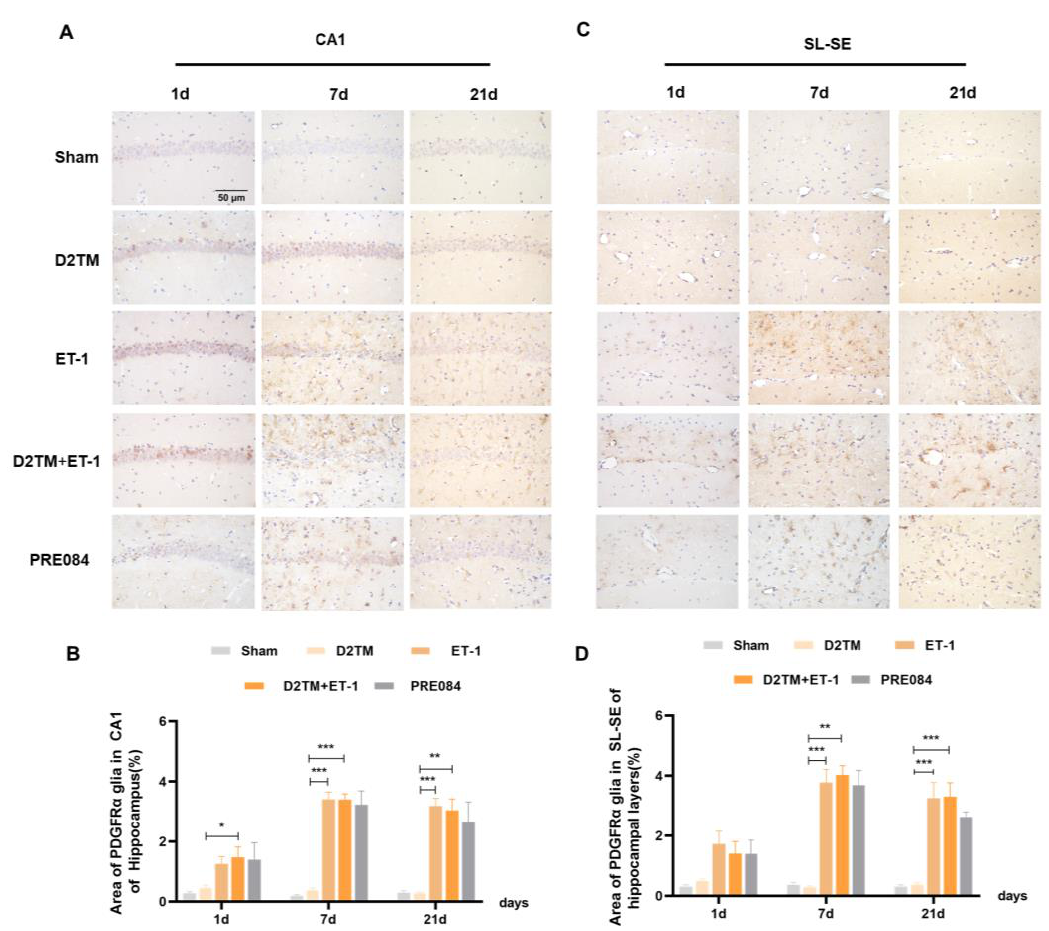
Figure 9. PRE084 regulated the expression of PDGFR α in stroke in diabetic mice. ( A , C ) PDGFR α immunohistochemistry was performed to detect oligodendrocyte progenitor in the CA1 and the SL–SE hippocampal layers at 1, 7, and 21 d after ET-1 injection. ( B , D ) Quantification of the area of the PDGF α -immunostained cells in the CA1 and SL–SE of the hippocampus. n = 4–5/group. Scale bars = 50 µ m. * p < 0.05, ** p < 0.01, *** p < 0.001.